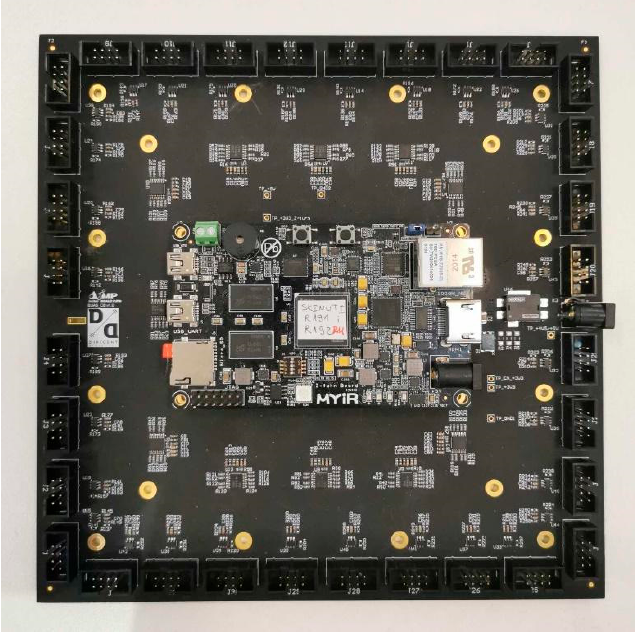
Figure 8. Assembled signal acquisition, data processing, and interface module.